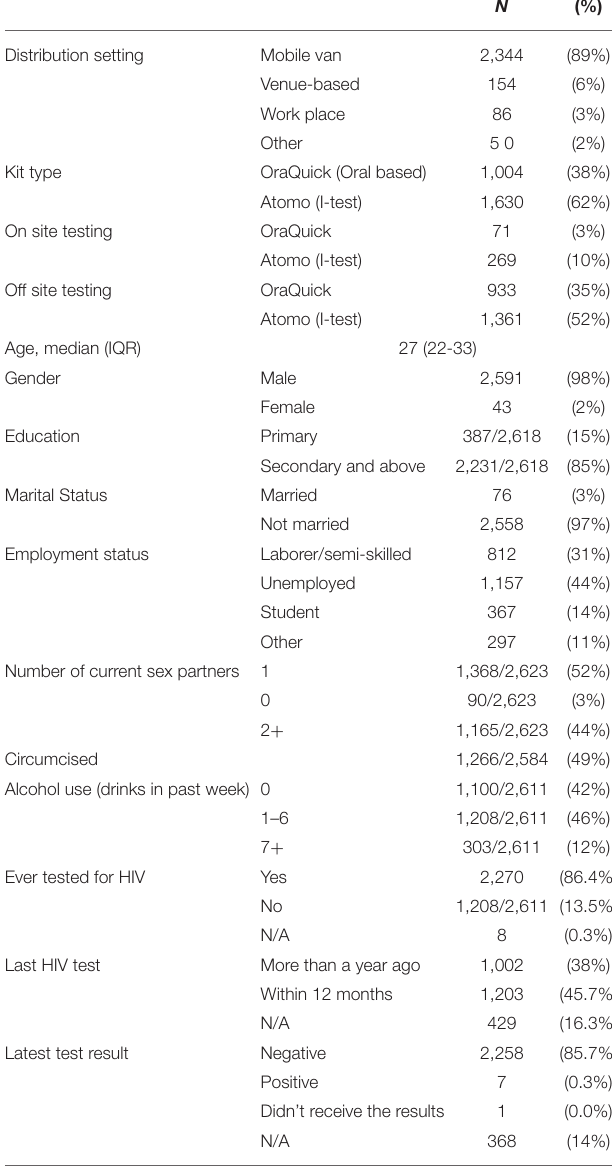
TABLE 1 | Characteristics of HIVST kit